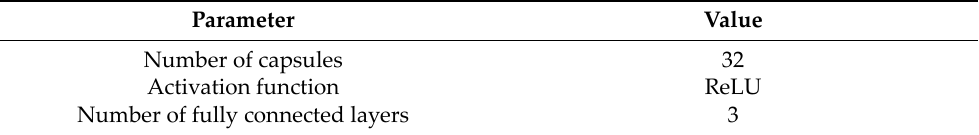
Table 5. Two‑layer CapsNet (TL‑CapsNet) algorithm parameters